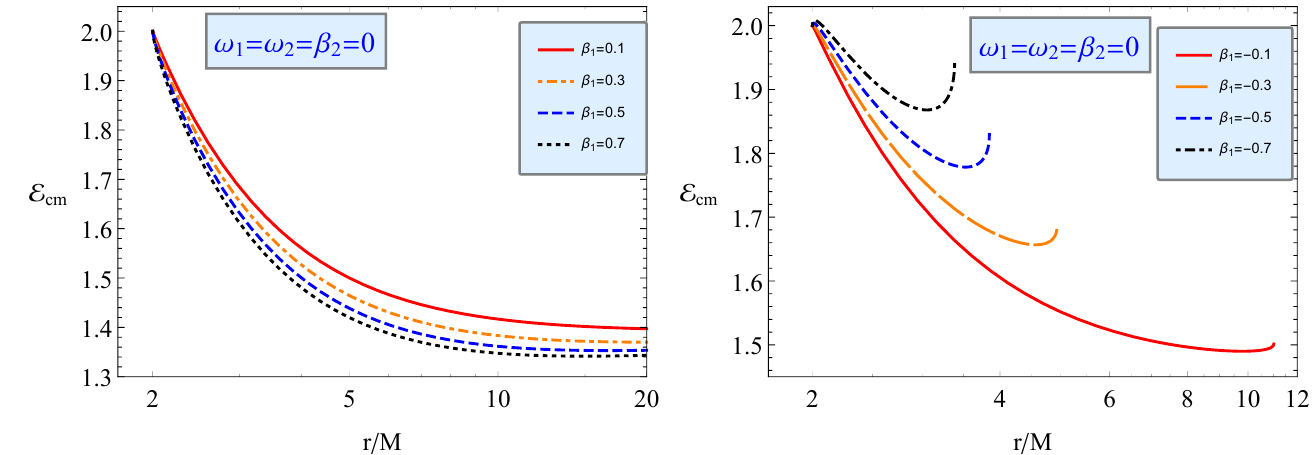
Figure 10. The same as Figure 9 but for collisions of neutral-magnetized particles with positive magnetic dipole particles.